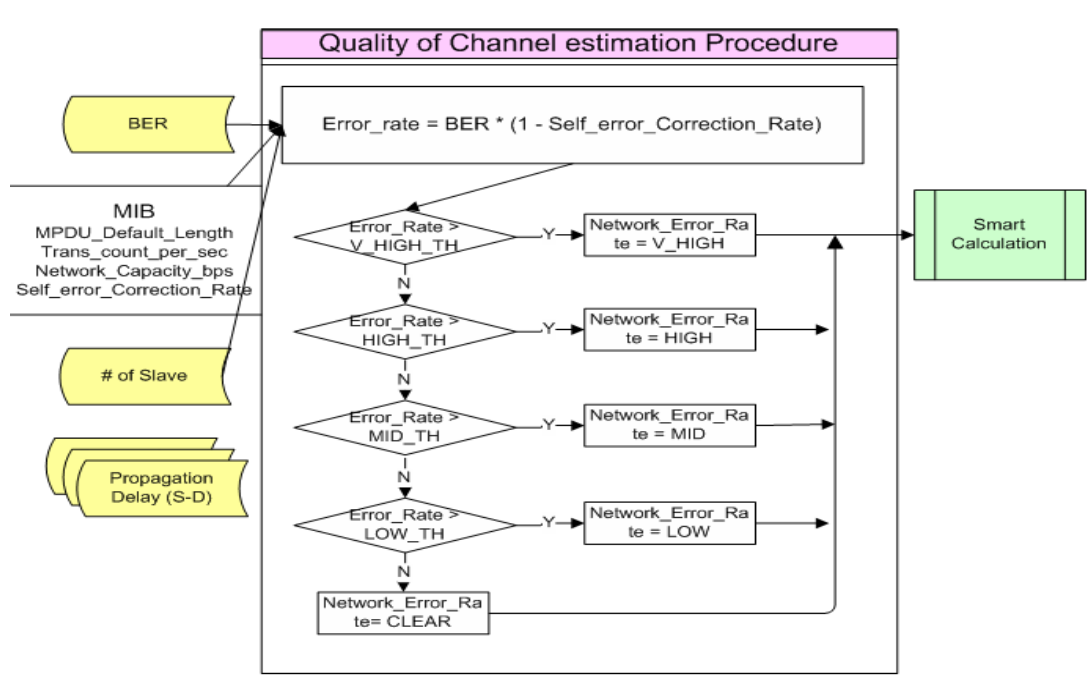
Figure 6. Quality of Channel estimation